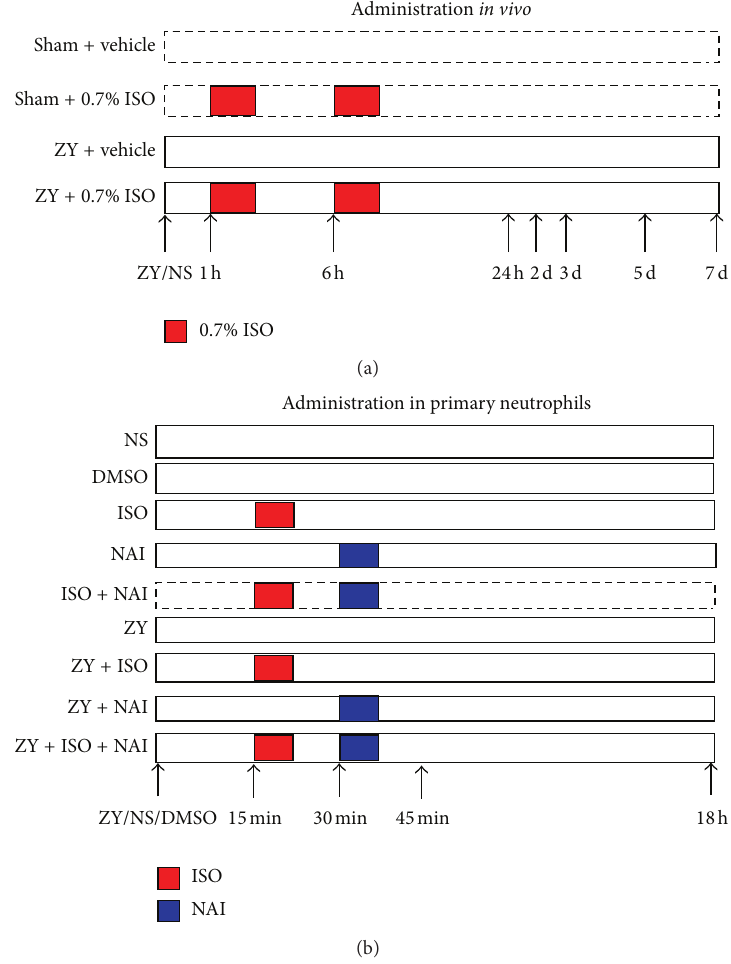
Figure 1: Schematic diagram depicting the experimental designs for this study. (a) Four treatment groups were used for in vivo experiments. At 1 and 6hrs after NS (sham) or ZY injection, mice were subjected to inhalation of 0.7% ISO or RA (vehicle) for a 1hr duration. BALF and lung tissues were harvested for a series of assays at 24hrs following NS or ZY administration. (b) Test and control groups for 0.7% ISO treatment of isolated neutrophils. At 45mins or 18hrs after single or combined treatments with ZY, ISO or NF- 𝜅 B activation inhibitor (NAI) in neutrophils, assays for NF- 𝜅 B DNA-binding activity, iNOS activity, and NO formation were performed. DMSO was assayed as a solvent control. For more detailed descriptions, see Section